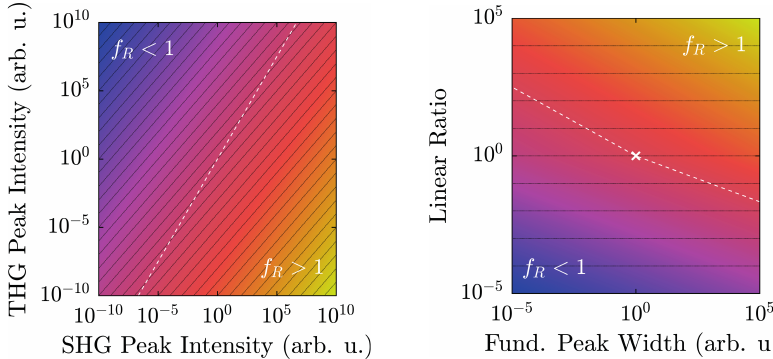
( f R ) as a function of spectral peak intensities according to Figure 1. Logarithmized harmonic ratio log 10 Equation (6) with s = 1 ( left ) and as a function of the spectral peak width and the linear ratio A 2 ω / A 3 ω with max ( A 2 ω , A 3 ω ) = 1 ( right ). The white dashed line marks value-pairs where f R = 1, whereas black lines illustrate equal ratios between second harmonic generation (SHG)- and third harmonic generation (THG)-peaks. Values scale from blue over red to yellow.